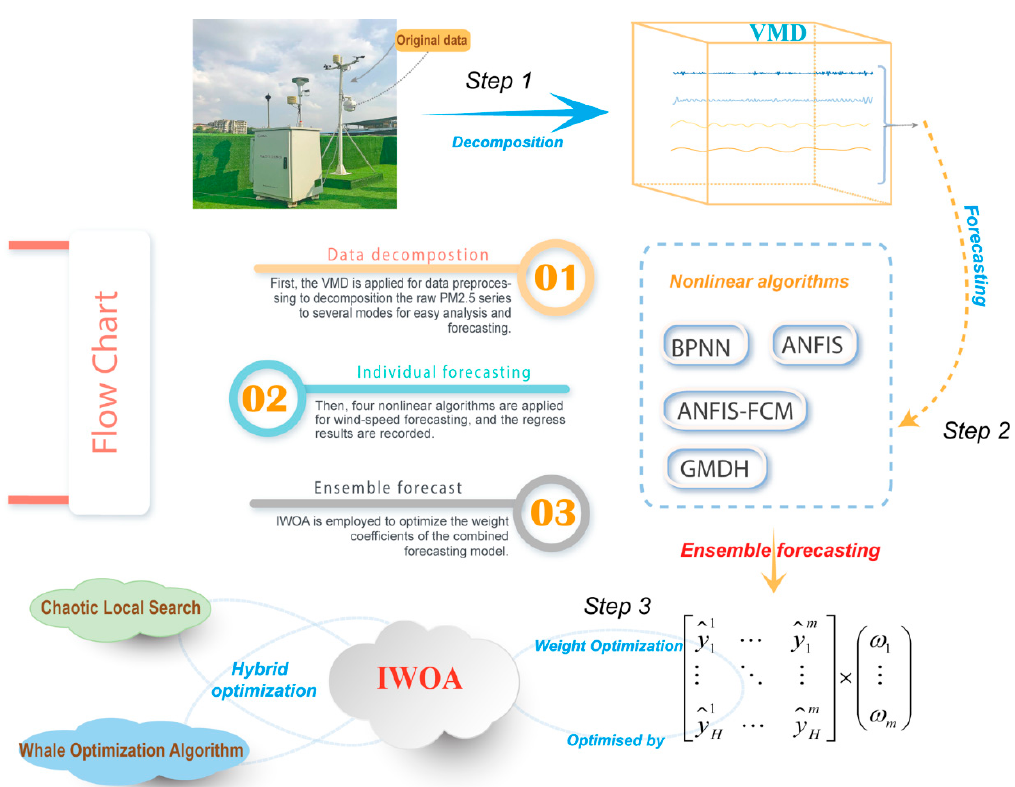
Figure 1. The main procedures of the combinatorial model proposed in the paper. Step 1: Variation mode decomposition (VMD) process; Step 2: Ensemble forecasting on variational modes (VMs); Step 3: Assemble forecasting results.